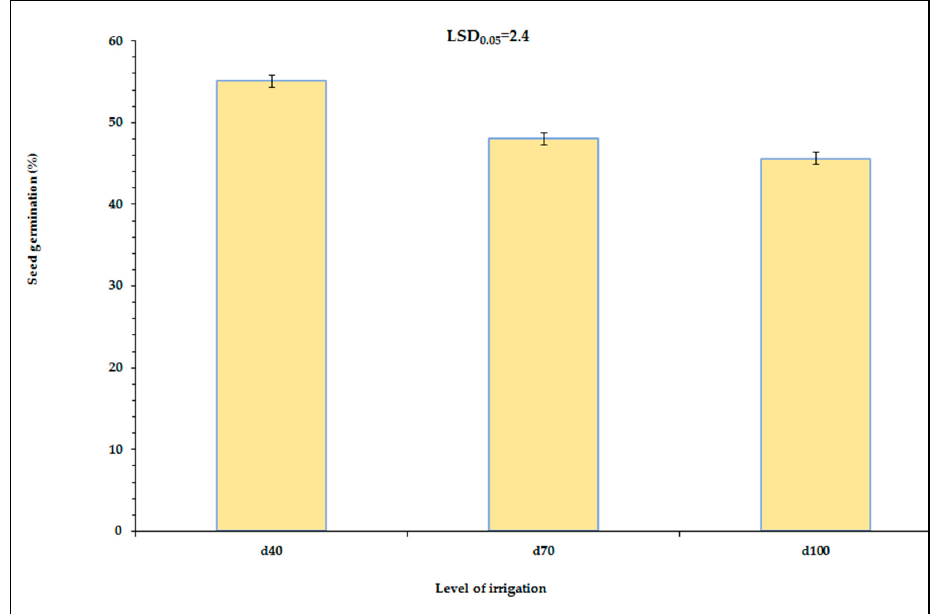
Figure 3. Main effect of irrigation (d 40 , d 70 , and d 100 ) on seed germination. Data presented are estimated mean values averaged over all combinations of the levels of the other effects (year, cultivar and PEG concentrations). LSD is the least significant difference at the 0.05 significance level. Error bars correspond to the estimated common standard error of the mean values. Each mean value has been estimated utilizing n = 160 measurements. Figure S3 (see Supplementary Material) presents the observed mean values and the corresponding individual standard errors.